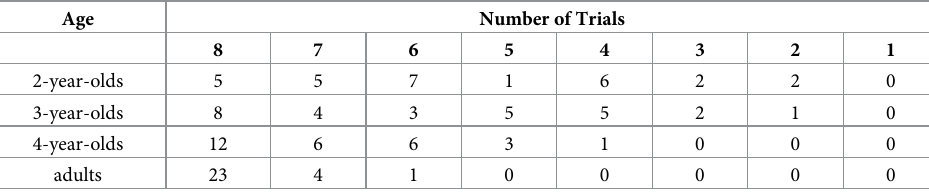
Table 4. The number of participants who responded correctly across ages.